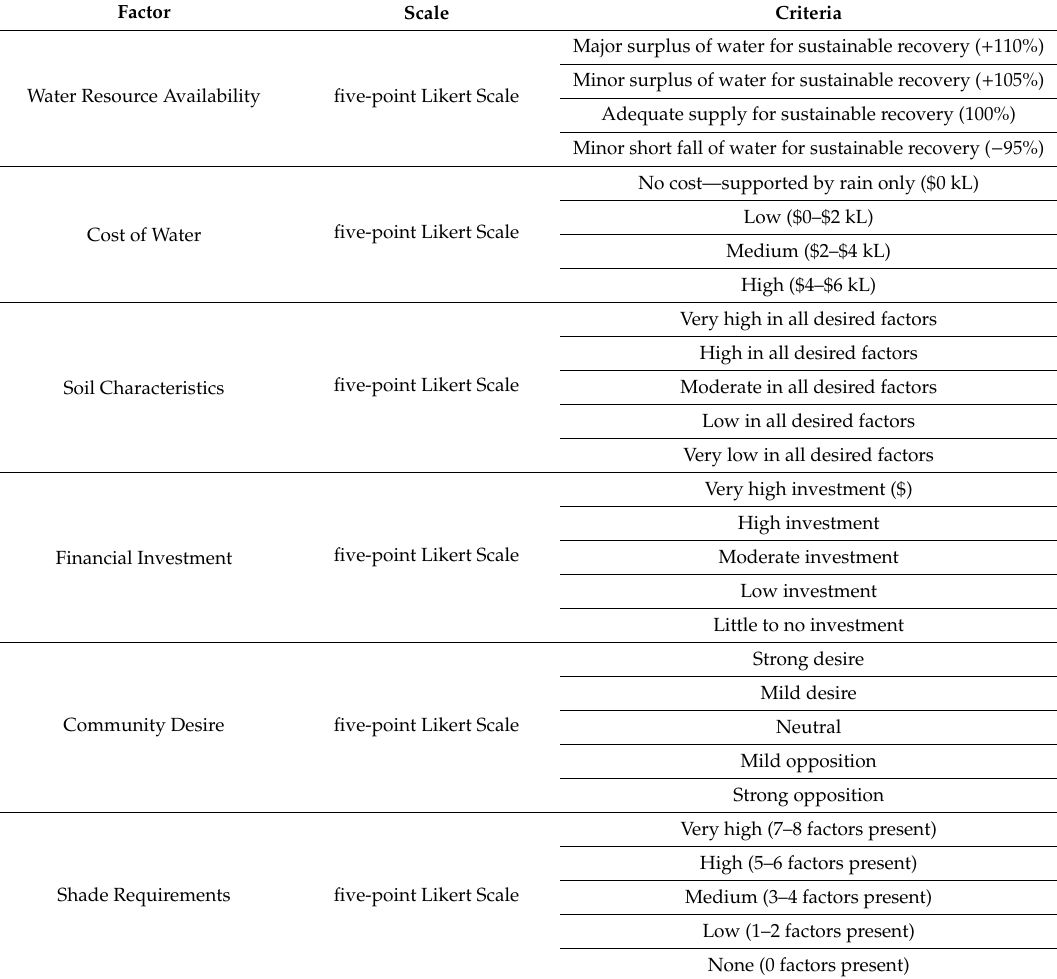
Table 3. Factors identified as influencing the ability of an urban center to support and require tree canopy cover with scaling